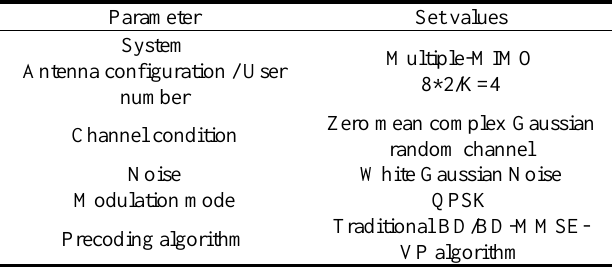
Table 1. Multi-User MIMO precoding